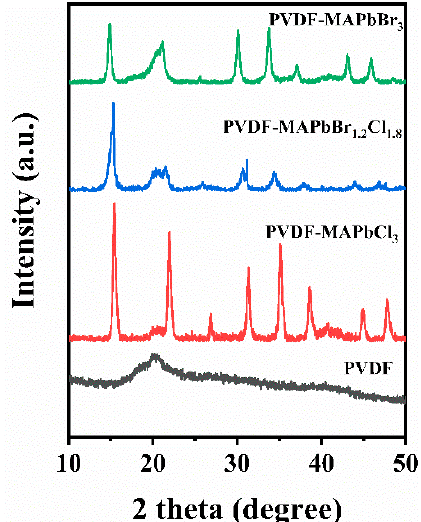
Figure 2. The X-ray diffraction (XRD) patterns of the PVDF-MAPbBr 3 − x Cl x (x = 1.0, 1.8, 3.0) membranes and the PVDF membrane.